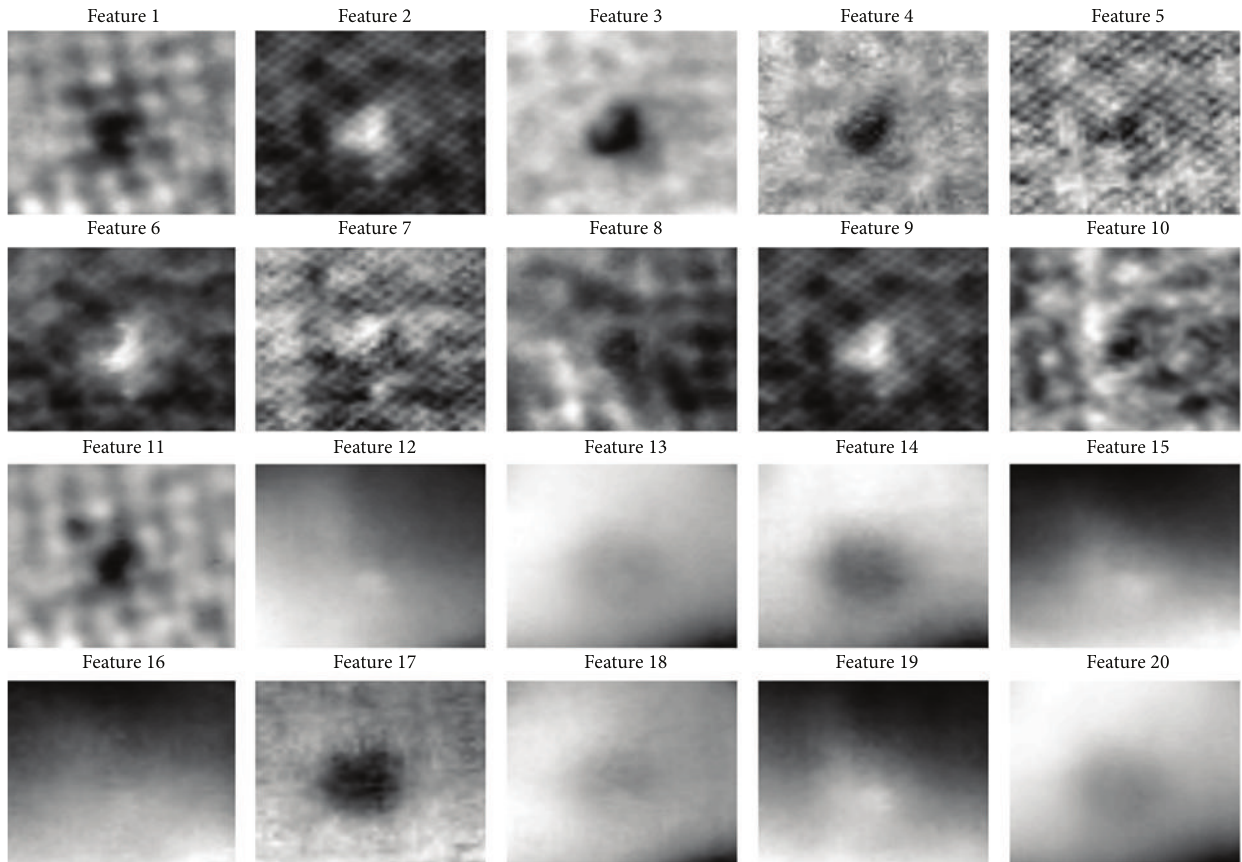
Figure 12: Results of the data registration process carried out for features vector obtained for sample impacted by 2J.